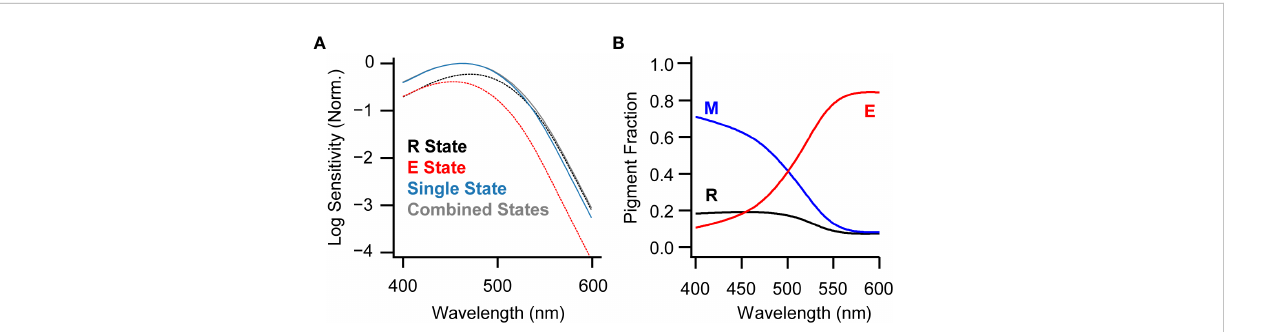
FIGURE 2 Melanopsin states under broadband and narrowband illumination. (A) Fits made to the action spectrum measured from ipRGCs on a background of broadband white light (21) using either a single-state nomogram (blue; l max = 463 nm when fi t on linear scale) or the combination of the R and E spectra (gray; l max = 463 nm). Black and red dotted lines represent the R and E state nomograms, respectively, scaled to their contributions to the combined fi t and using l max values measured electrophysiologically (471 and 453 nm, respectively). The l max of the combined nomogram, when fi t on a log scale, is 480 nm. (B) Melanopsin states at photoequilibrium for monochromatic illumination with wavelengths spanning the visible range, predicted by a model based on biochemical parameters of mouse melanopsin